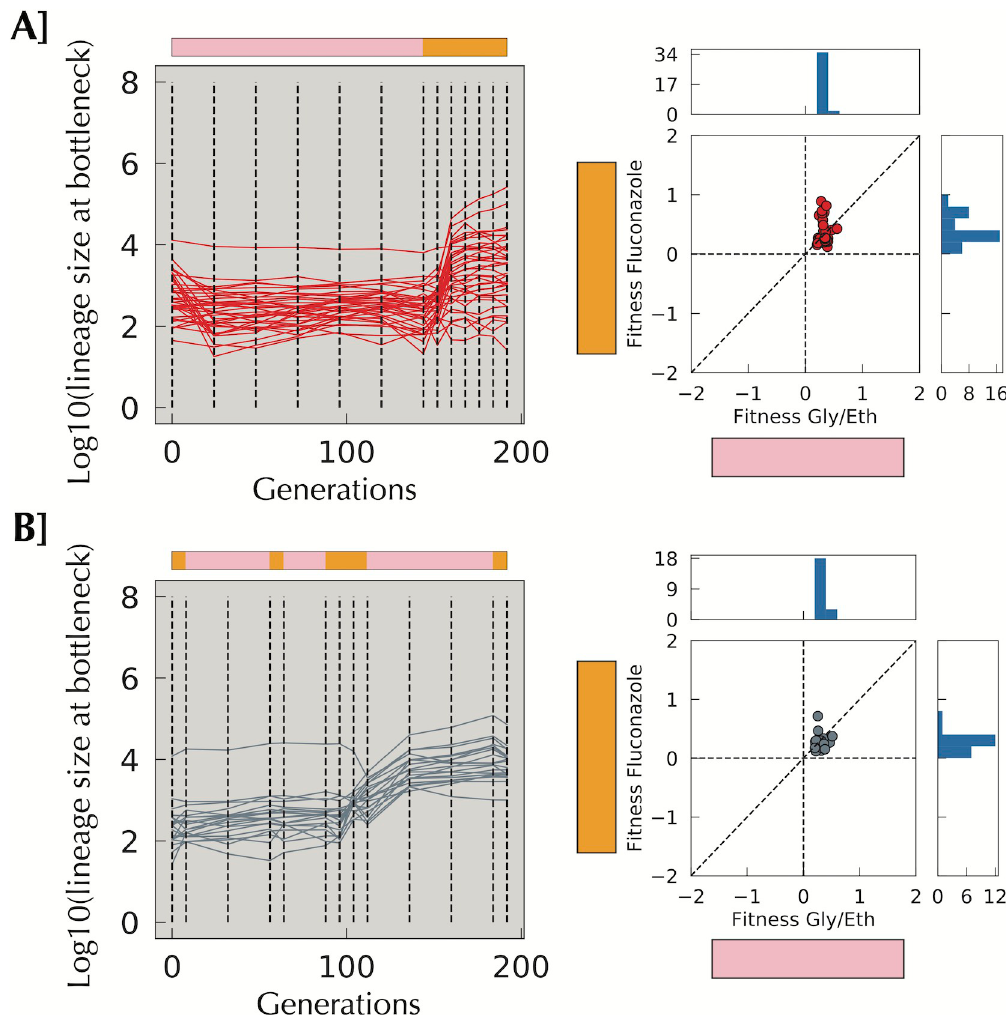
Fig 4. A change in the environment aids selection of lineages with high fitness in Gly/Eth. A] Lineages isolated from switch_adap2 having an average slope per cycle smaller than 0.08 in the Gly/Eth environment during the evolution yet have a remeasured fitness per cycle in Gly/Eth of > 0.2. Those fit Gly/Eth mutants were not able to reach high frequency in 144 generations in Gly/Eth, yet considerably increased their frequency during 48 generations in Fluconazole. B] A similar phenomenon is seen in Random_smaller2. The Fluconazole episode has reshuffled lineage frequencies: some frequent lineages decrease, while others increase. When the population goes back to Gly/Eth, a large increase in frequency can be